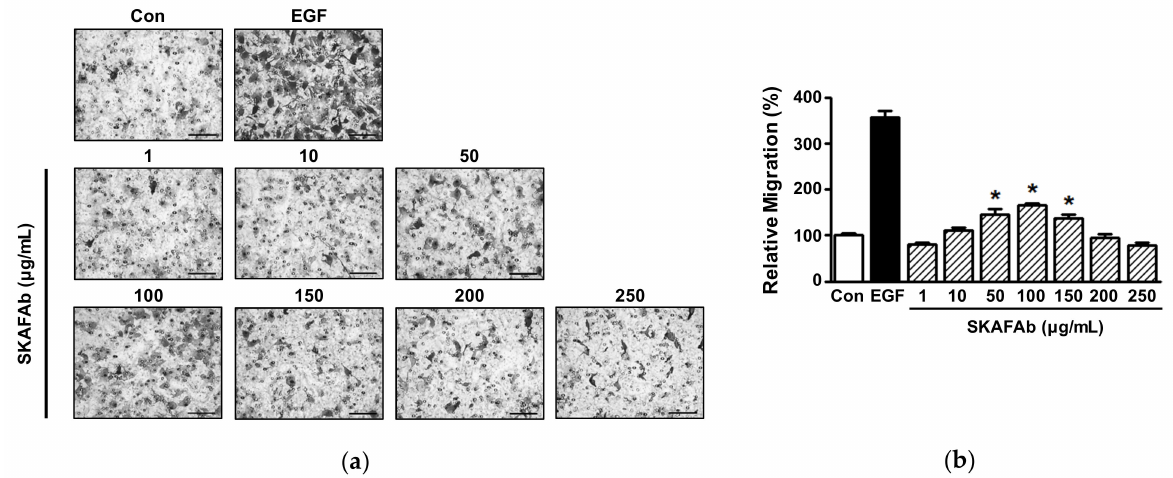
Figure 3. Effects of Salix koreensis Anderss flower absolute on keratinocyte migration. HaCaT cells were treated with or without Salix koreensis Anderss flower absolute (SKAFAb; 1–250 µ g/mL) for 210 min. Cell migration levels were assessed using a Boyden microchemotaxis chamber assay. ( a ) Representative images. Black spots indicate migrating cells. ( b ) Statistical graph.